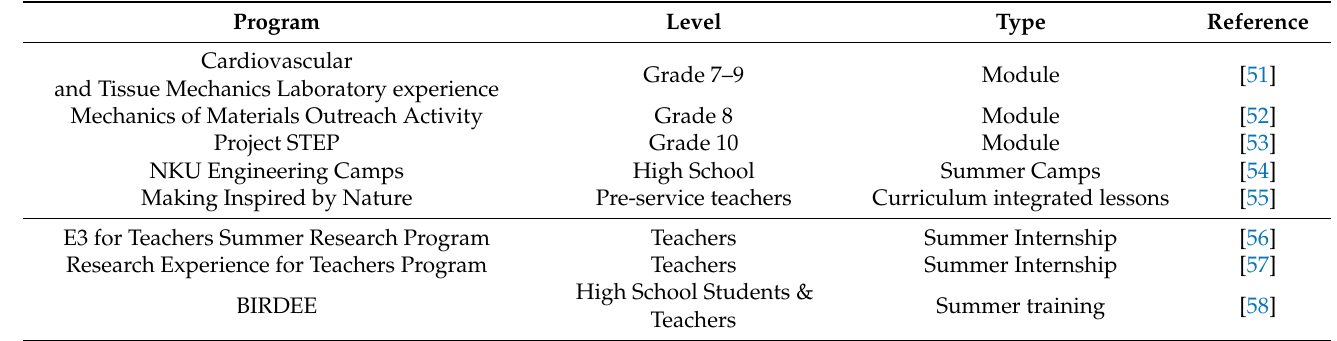
Table 1. Examples of K-12 biom* education programs for students or